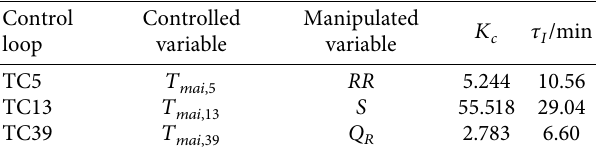
Figure 3: Temperature control structure CS1 of DWC. Table 2: Controller tuning parameters of